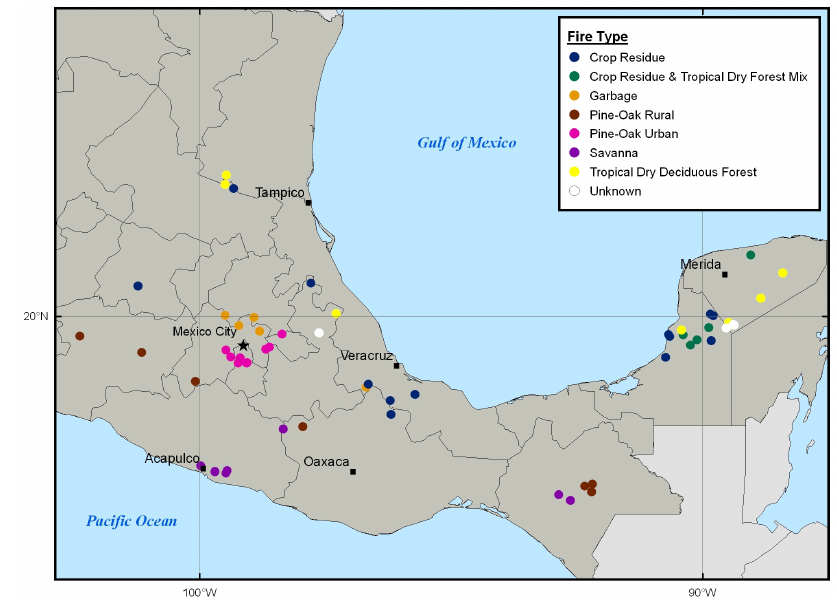
Fig. 1. Map showing location of open biomass burning sampled in Mexico in 2006 and